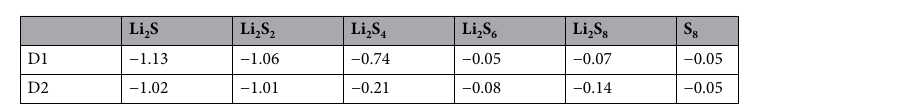
Table 2. Calculated charge transferred (in e) to the defected BPN sheet from LiPSs and S 8 cluster after adsorption.